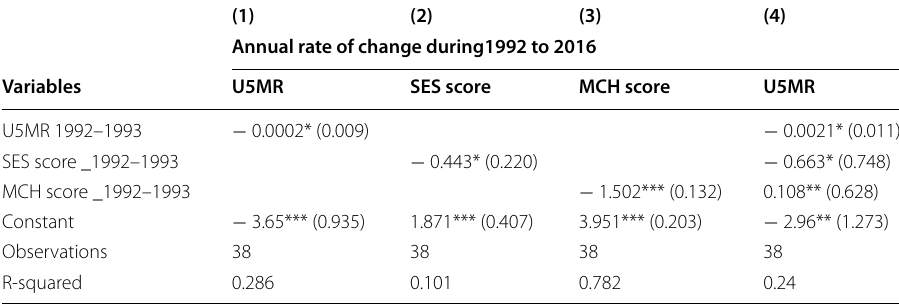
Table 5 Absolute and conditional β-convergence analyses of SES and MCH scores across Hindus and Muslims in